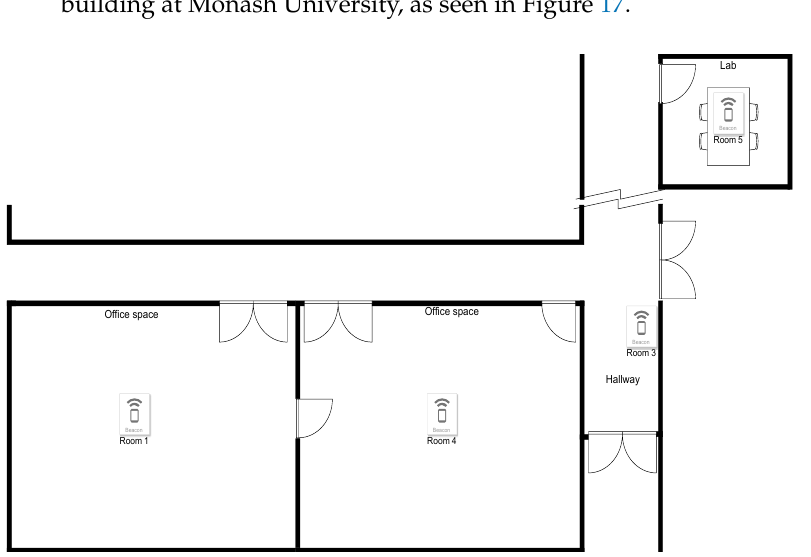
Figure 17. Layout of beacons in test environment at the ECSE building at Monash